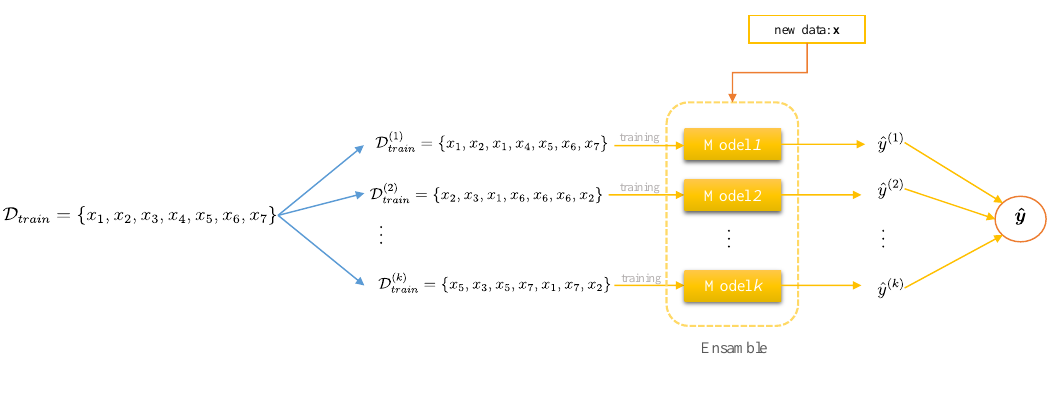
Figure 2. Bagging